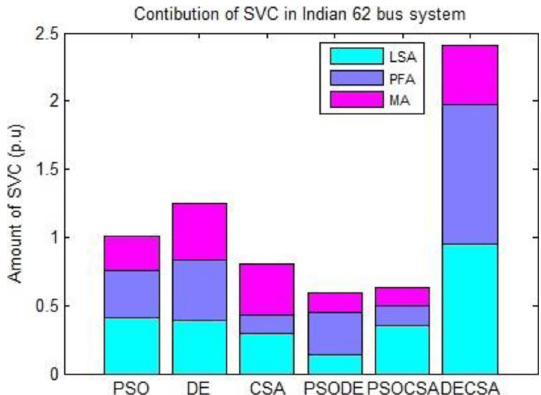
Fig. 6 Amount of SVC contributions at Weak nodes